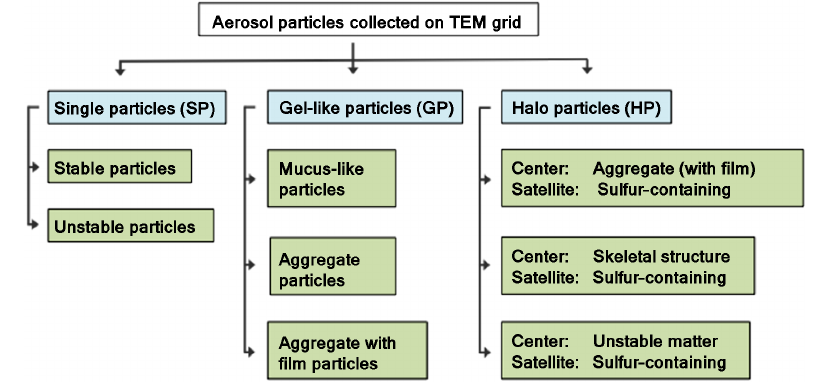
Figure 2. Scheme of the aerosol particle types collected on Formvar grid; the particles observed with SEM are shaded in light blue, and particles observed in TEM are shaded in light green.